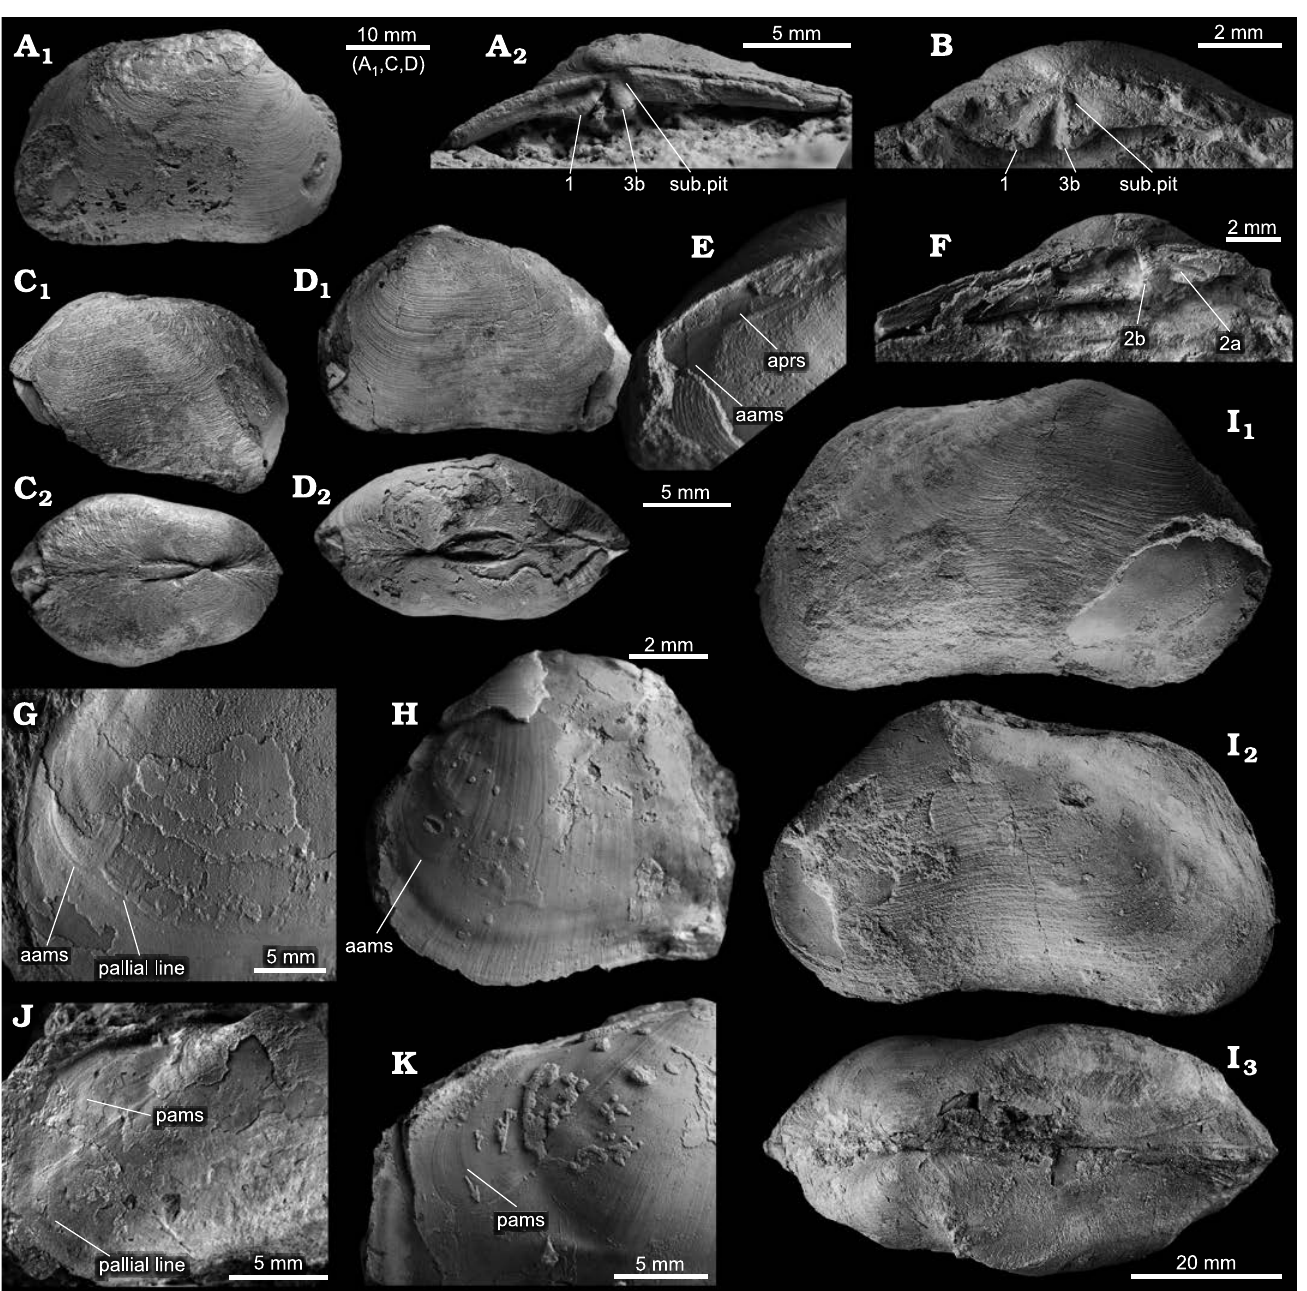
Fig. 17. The bivalve Sisonia frijellanae gen. et sp. nov. from Upper Miocene seep deposits of the Amlang Formation in Pangasinan province, Luzon, Philippines. A . NIGSPAL-030, holotype, articulated specimen with exposed RV hinge; view on exterior of RV (A 1 ), close-up on hinge of RV (A 2 ). B . NRM Mo 192594, hinge of isolated right valve. C . NRM Mo 192707, articulated specimen with ventral side missing, view on left valve (C 1 ) and dorsal view showing inflation and short ligament (C 2 ). D . NRM Mo 192595, paratype, articulated specimen, view on left valve (D 1 ) and dorsal view (D 2 ). E . NRM Mo 192596, paratype, close-up on anterior side of left valve of an articulated specimen, showing aams and aprs. F . NRM Mo 192598, paratype, hinge of isolated left valve. G . NRM Mo 192673, close-up on anterior side of isolated internal mold of left valve, showing aams and pallial line. H . NRM Mo 192596, paratype, close-up on anterior side of isolated internal mold of left valve, showing aams and internal, radial striation. I . NRM Mo 192674, paratype, very large specimen with mostly intact shell, views on right valve (I 1 ), left valve (I 2 ) and on dorsal side showing median sulcus and posterior ridge (I 3 ). J . NRM Mo 192703, close-up on posterior side of RV showing pams and pallial line. K . NRM Mo 192704, close-up on posterior side of RV showing pams. Abbreviations: aams, anterior adductor muscle scar; aprs, anterior pedal retractor scar; pams, posterior adductor muscle scar; sub.pit, subumbonal pit; cardinal teeth numbers indicated in images A 2 , B and